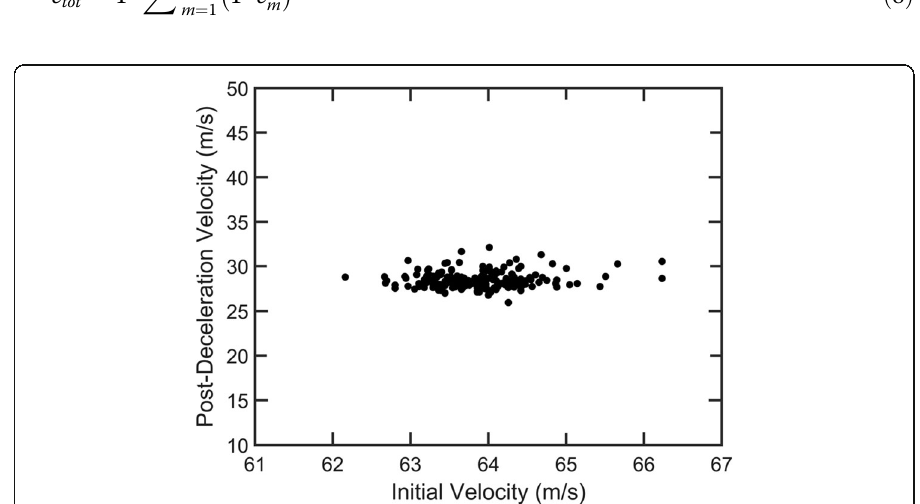
Fig. 12 Decelerated velocity distribution for 990 nm PSL particles. Initial energy-per-charge of particles is 400 eV with a decelerating potential of +35 V on each of the 9